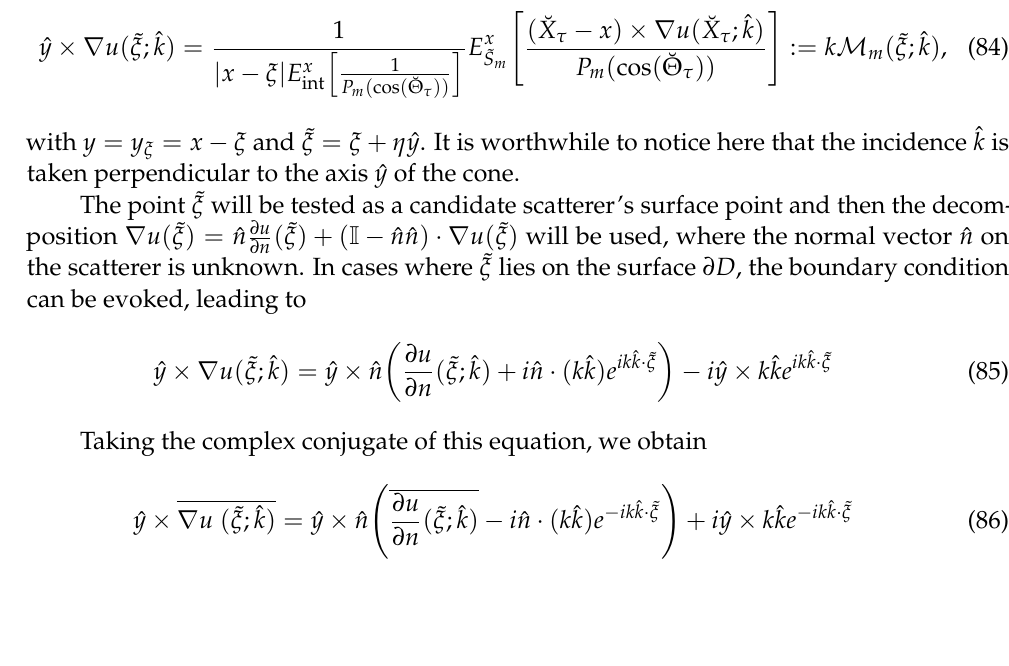
Figure 11. Every cone has a height that cannot exceed e m versions of the corresponding cones are